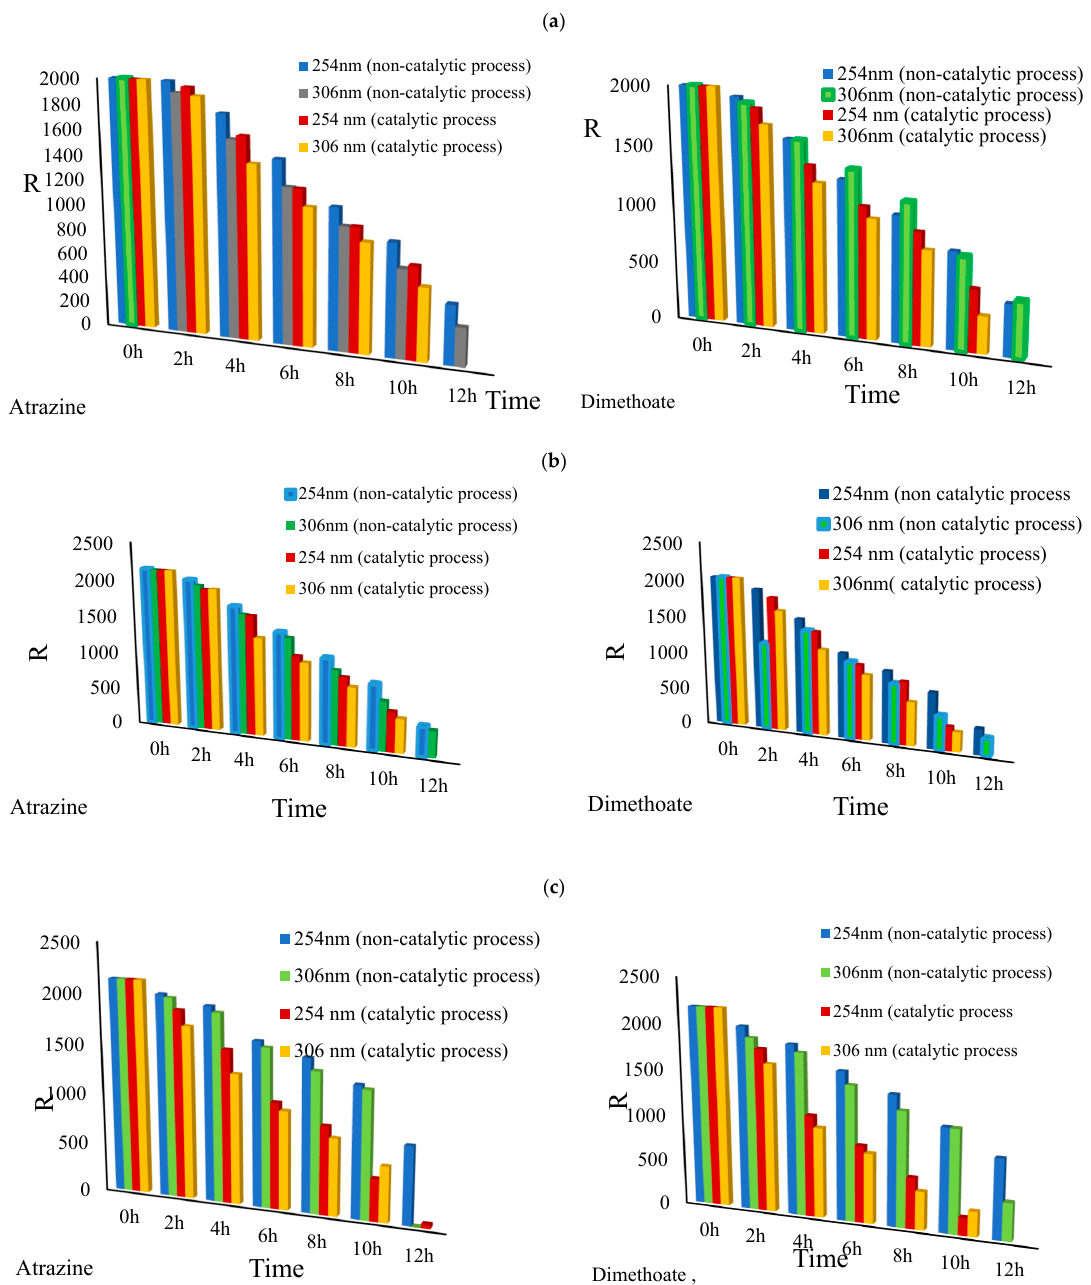
Figure 4. Concentration of pesticides (R = ppb) as a function exposure time of irradiation at both wavelengths of ultraviolet (UV) for the photo-remediation process, with and without catalyst, of pesticides; ( a ) AS, ( b ) WW, and ( c ) Ag.W.